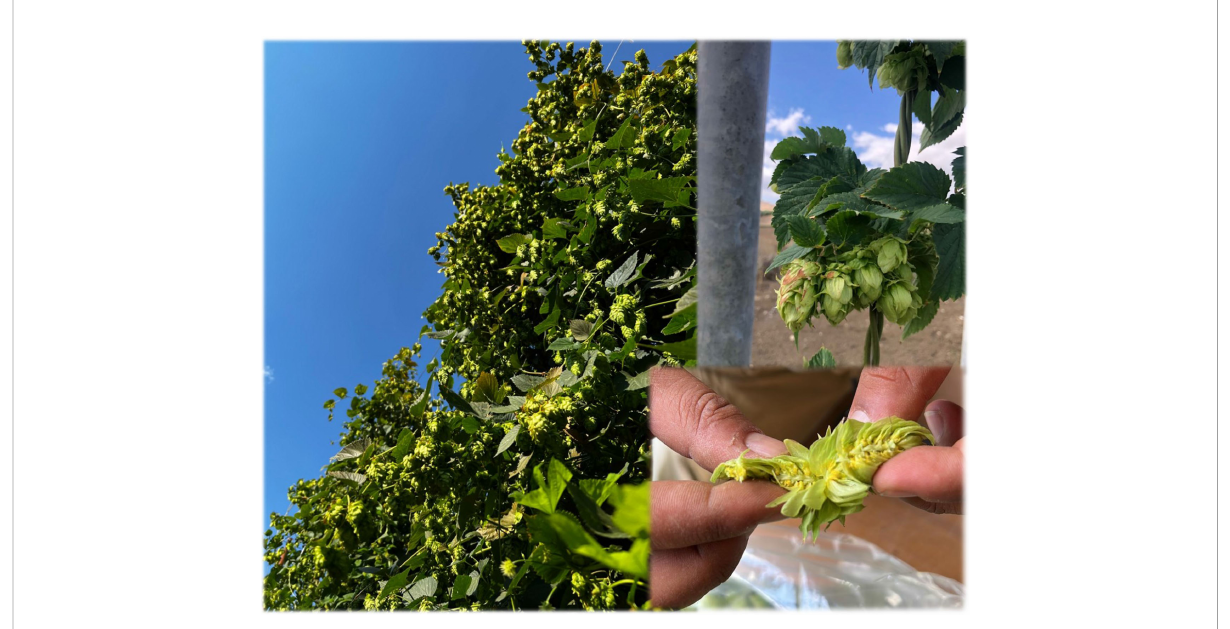
FIGURE 2 Hop bines before 2022 harvest at the “ Sparacia ” farm (37°38 ’ 07 ” N; 13°45 ’ 47 ” E; 450 m a.s.l.), Department of Agricultural, Food and Forest Sciences (D/SAAF), University of